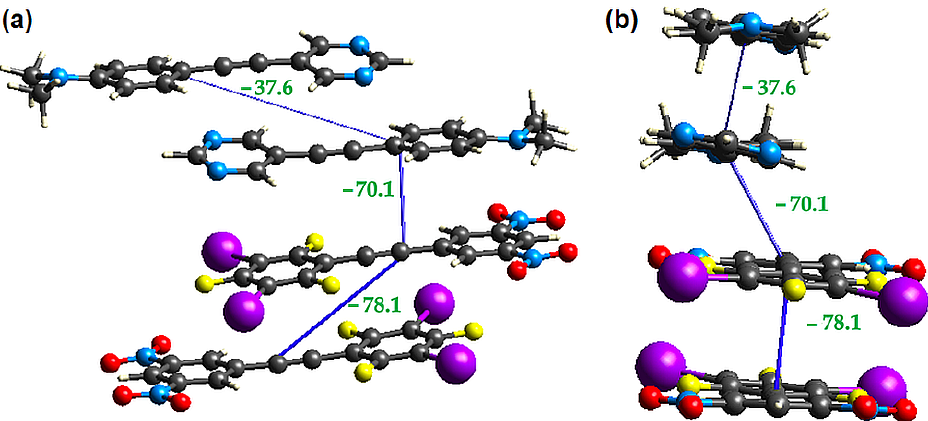
Figure 8. ( a ) Oblique view of the three unique stacking interactions 1-1 , 1-3 and 3-3 in the cocrystal 1 • 3 and view along the long axis of the four molecules in ( b ). Interactions’ energies (in kJ/mol) are in green. Table 1. Interaction energies (in kJ/mol) for the unique stacking interactions in the the cocrystal 1 • 3 . π π -Dimer